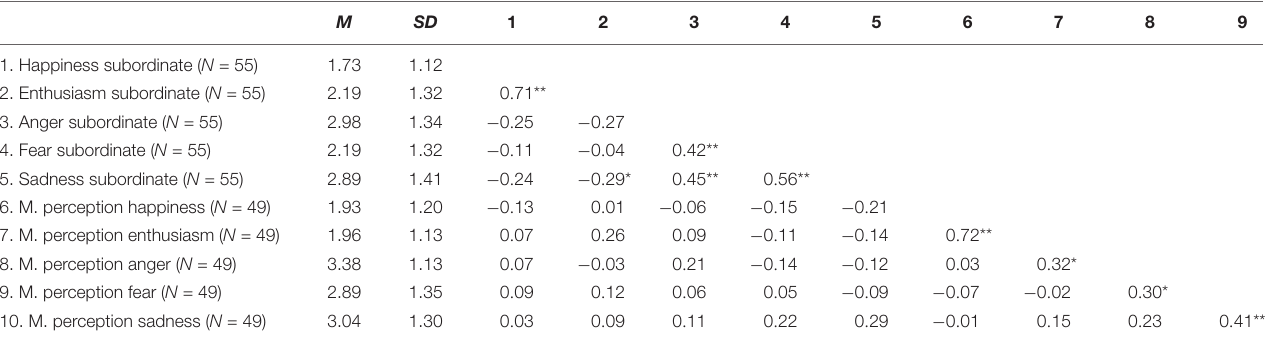
TABLE 3 | Means (M), standard deviations (SD), and correlations between subordinates’ emotions happiness, enthusiasm, anger, fear, sadness and mediator emotion perception. M SD 1 2 3 4